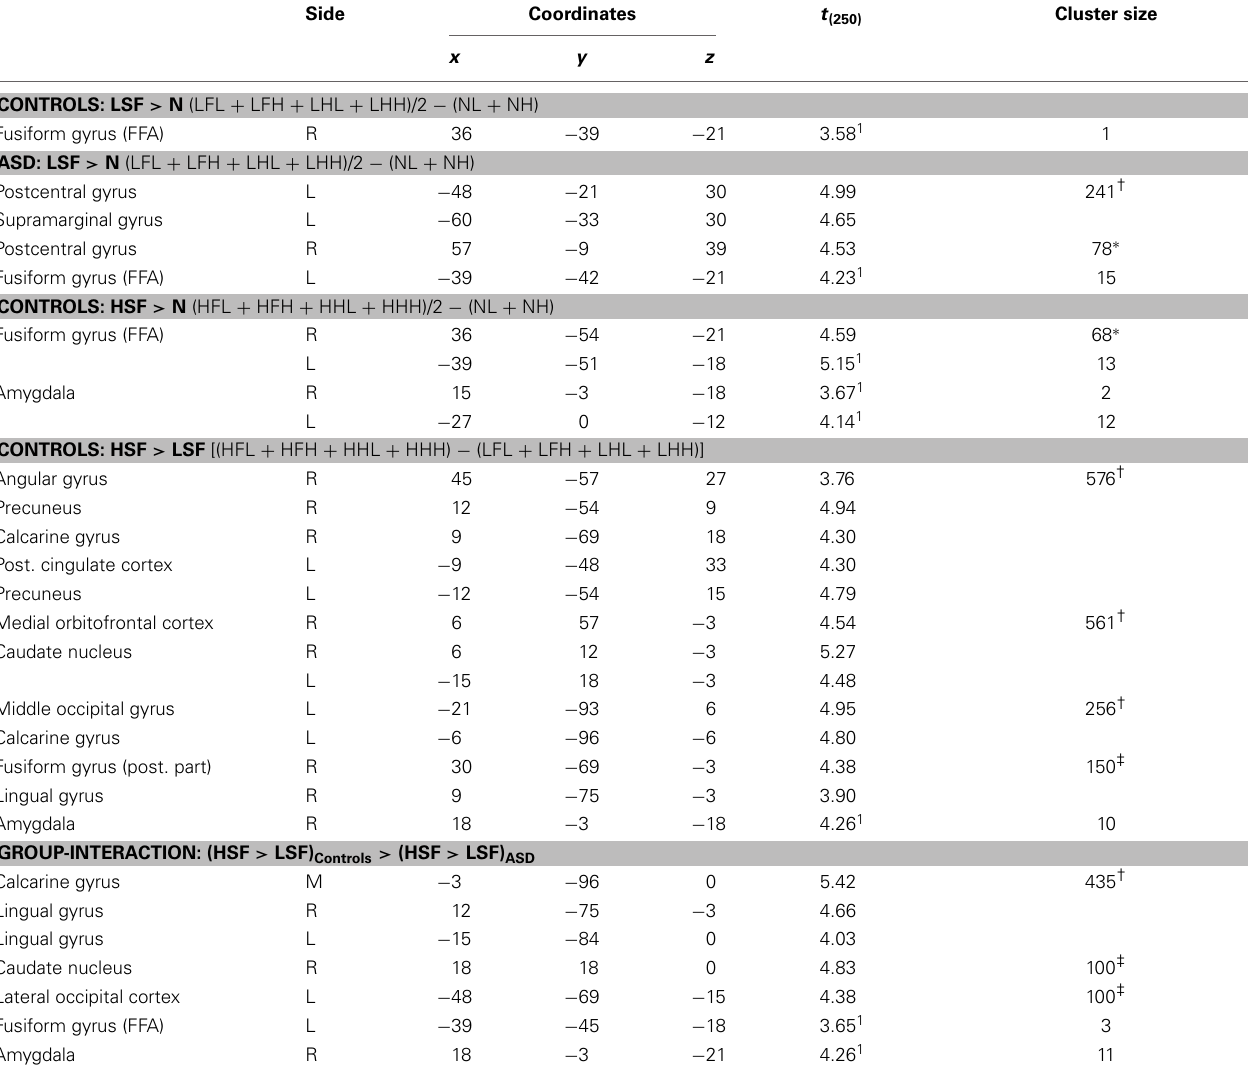
Table 3 | fMRI analysis: effects of HSF and LSF emotional cues. Side Coordinates t (250) Cluster size x y